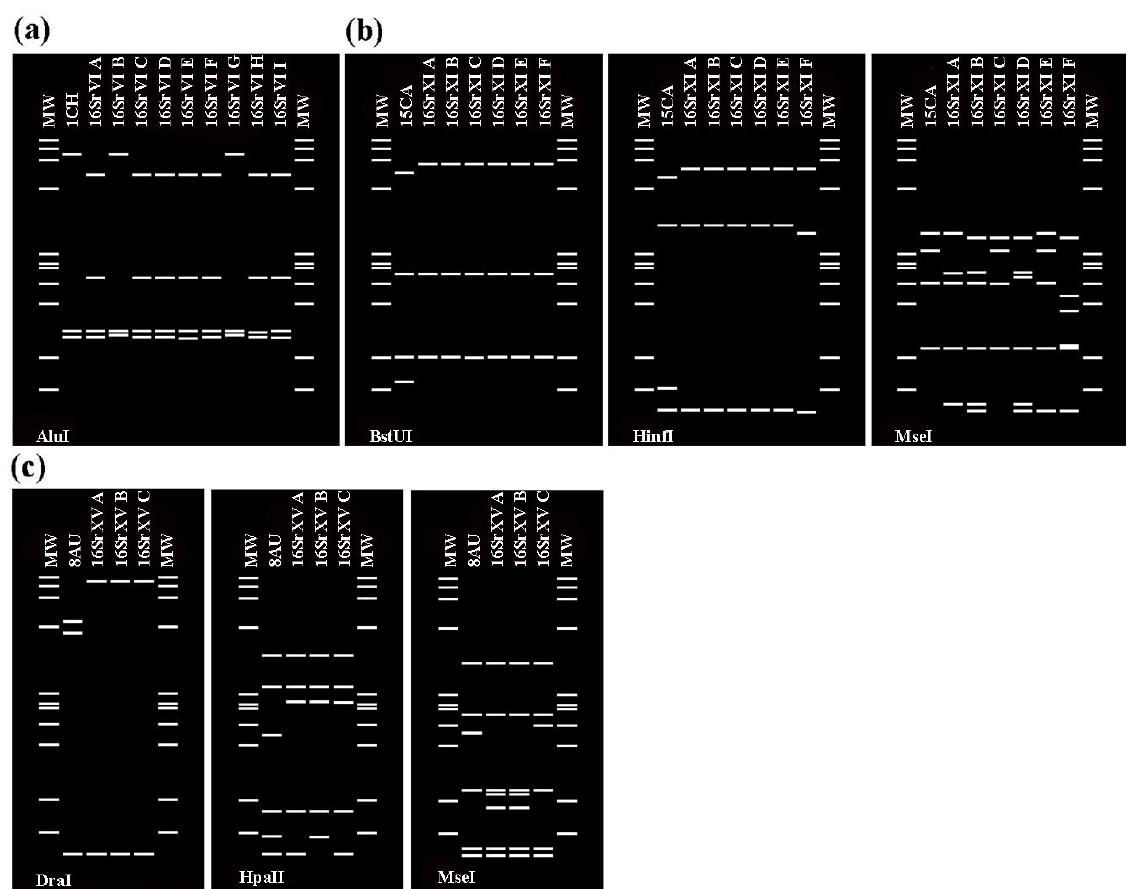
Figure 2. Identification of three new subgroups belonging to three different groups (16SrVI, 16SrXI, 16SrXV) based on the in silico RFLP patterns derived from key restriction endonucleases. ( a ) The new subgroup 16SrVI-L from the sample 1CH can be differentiated from the other nine subgroup profiles of the 16SrVI group by AluI restriction endonuclease. ( b ) The new subgroup 16SrXI-G from the sample 15CA can be differentiated from the other six subgroup profiles of the 16SrXI group by BstUI, Hinf and MseI restriction endonucleases. ( c ) The new subgroup 16SrXV-D from the sample 8AU can be differentiated from the other three subgroup profiles of the 16SrXV group by DraI, HpaII and MseI restriction endonucleases. MW, φ X174 DNA- HaeIII digestion as a marker.